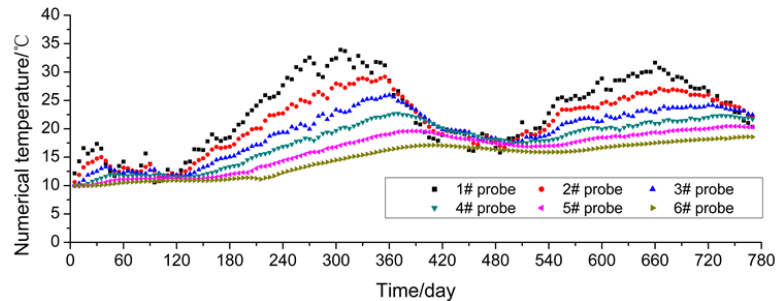
Figure 10. Temperature obtained from the numerical simulation.